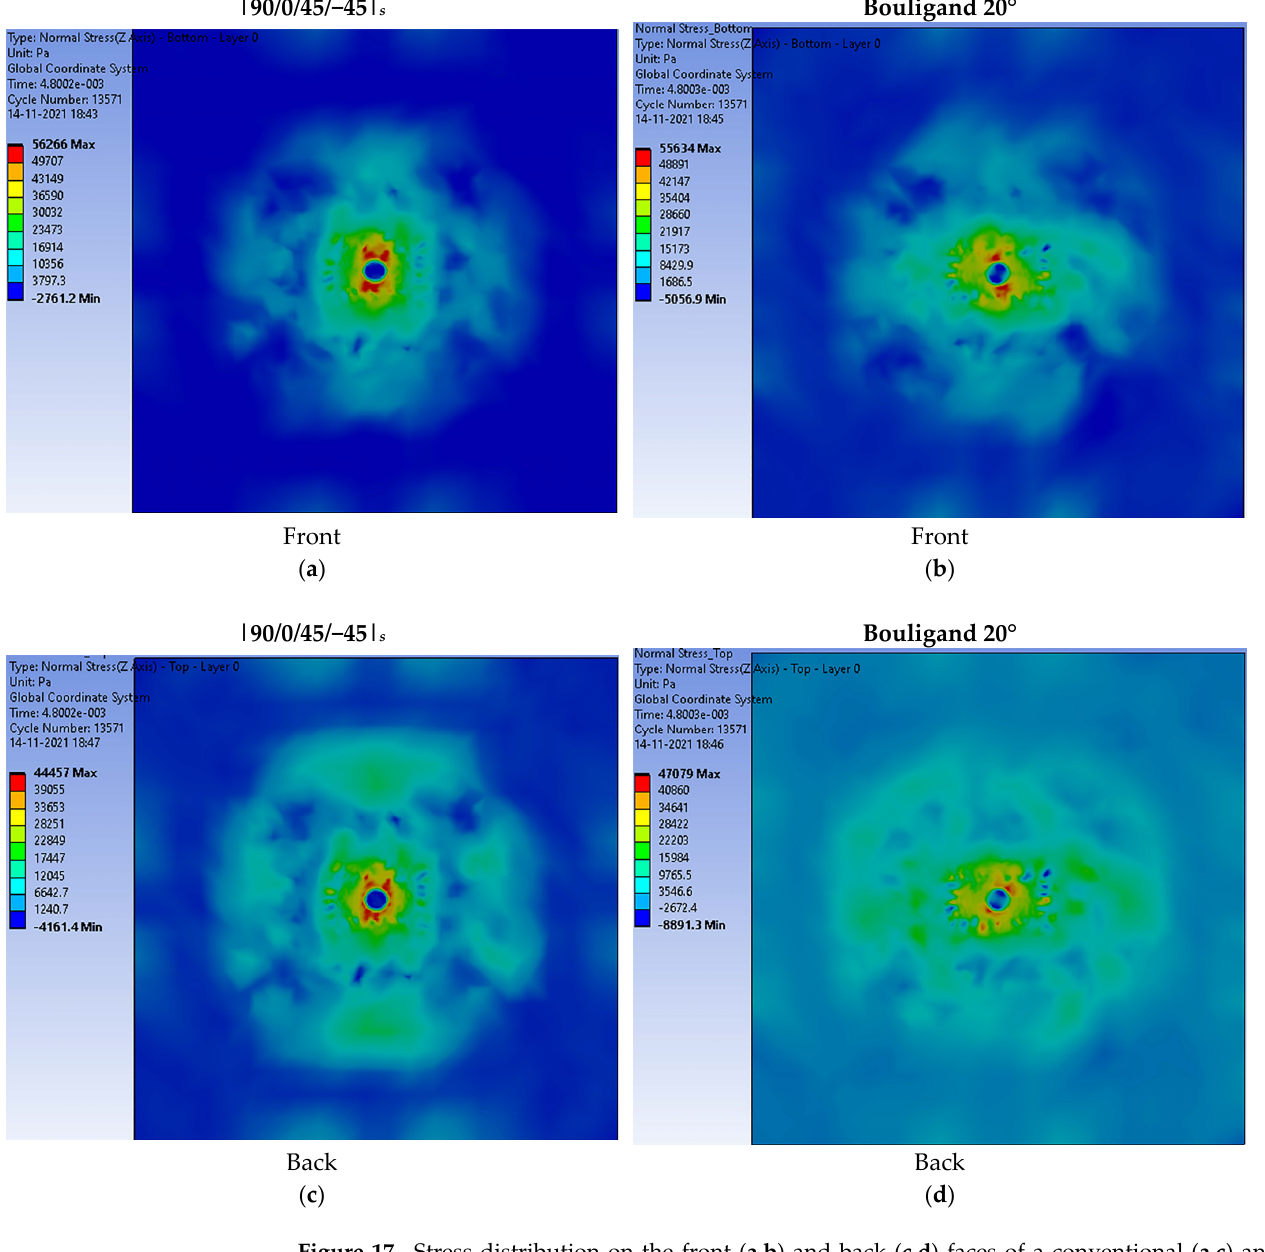
Figure 17. Stress distribution on the front ( a , b ) and back ( c , d ) faces of a conventional ( a , c ) and Bouligand ( b , d )